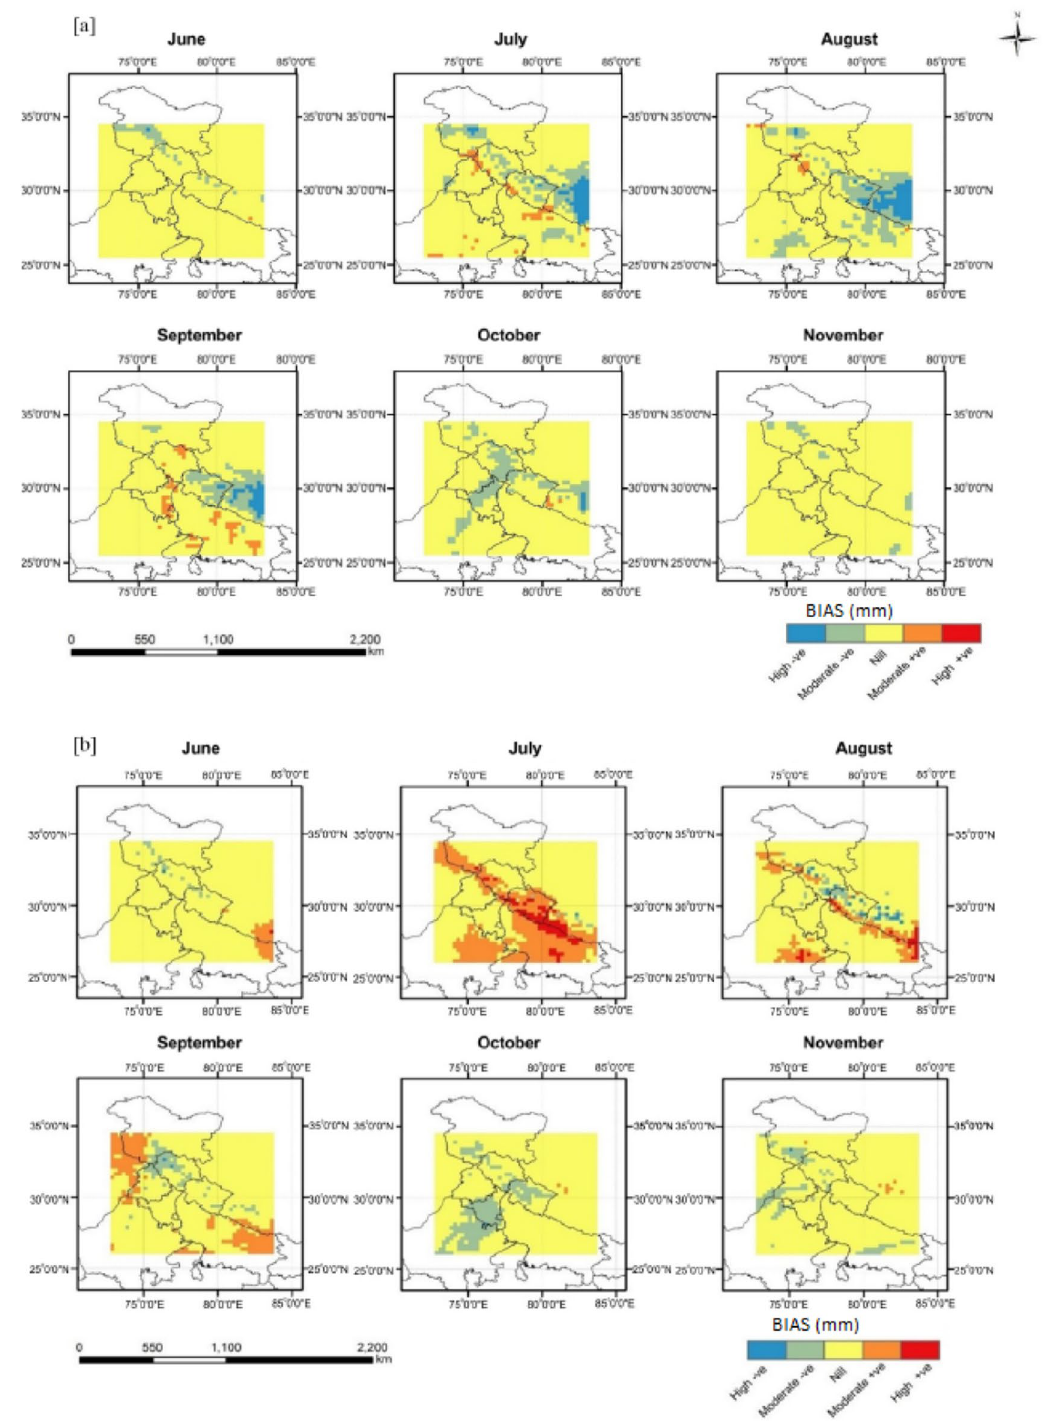
Figure 5. Spatiotemporal pattern of rainfall bias ( a ) 2009; ( b ) 2014 (Map created at IIRS—https:// www. iirs. gov. in/ inhou selab orato tion adequately modeled Haryana and Punjab’s crop yields with sufficient R 2 values of 0.62 and 0.74, respectively (Fig. 10). Prediction of yield loss during the 2009 drought. The anomaly of crop yield based on the mean and detrended yield for rice productivity was calculated to estimate the yield departure due to climatic variability. The relative detrended yield is the departure of yield values from the time-trend, assumed to take into account the technol- ogy and management component of yield. Figure 11 shows the district-wise rice yield anomaly based on average